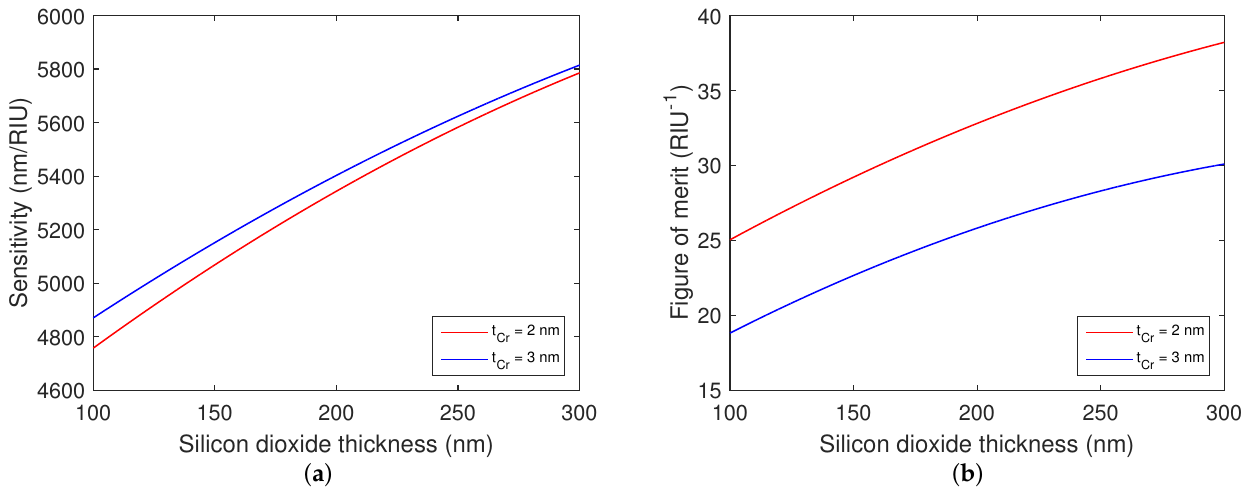
Figure 4. Theoretical RI sensitivity ( a ) and figure of merit ( b ) as a function of the silicon dioxide thickness when water was considered as an analyte. Gold layer thickness t Au = 38 nm. Silicon = 150 nm. Angle of incidence θ = 68 ◦ . dioxide thickness t SiO 2